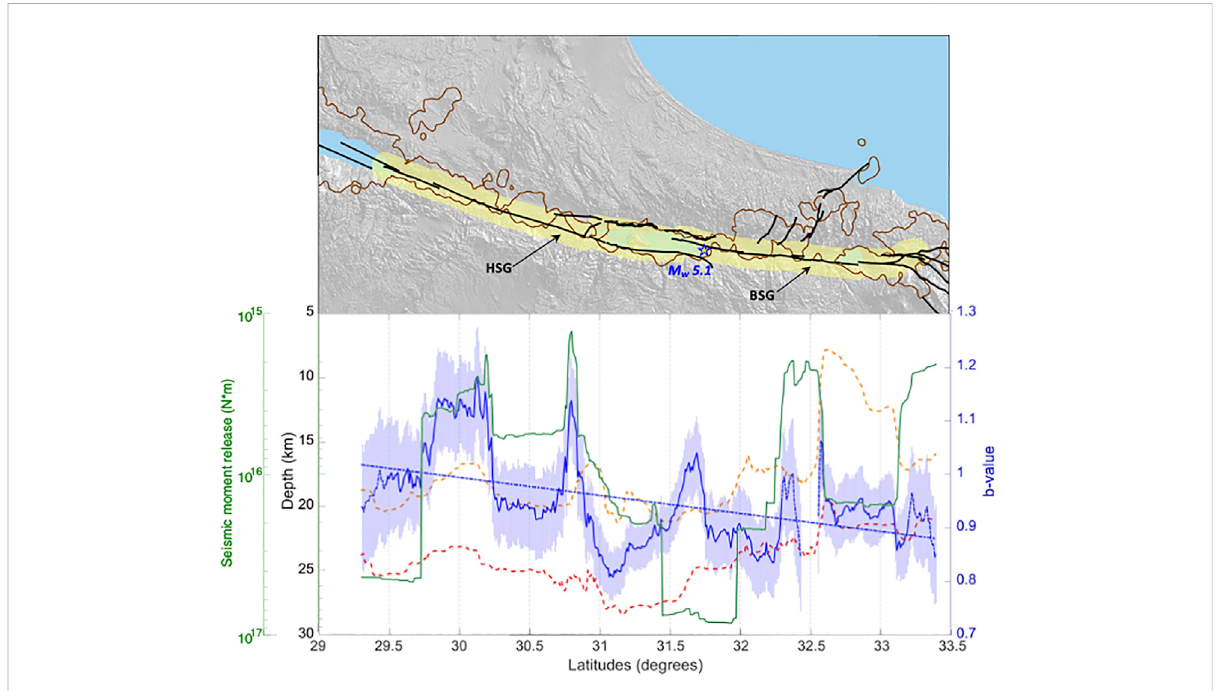
FIGURE 7 Top part: Map showing the DST polygon (yellow), de fi ning the data for the analysis. The black lines show the main sources (see Sharon et al., 2020). Bottom part: Spatial variations of the b-value (in blue), of the 75th and 95th hypocentre depth percentiles (dashed yellow and red lines, respectively) and of the cumulative seismic moment release (in Green). Note the left axes are directed downwards. Solid and dashed lines of the b-value indicate at least 100 events, and 50 – 99 events per sample, respectively, and are shown with their light blue error bar band surrounding them; the blue linear dashed curve marks the spatial trend of the b-value . Within the Top part, the brown polygon marks zones with high values of seismic density and seismic moment density (see Sharon et al., 2020), overlapping the DST polygon. These zones emphasize two seismic gaps: 1) HSG — Hazeva Seismic Gap (latitudes ~30.7 ° – 30.8 ° N), and 2) BSG — Beit She ’ an Seismic Gap (latitudes ~32.4 ° – 32.6 ° N); the latter is prominent enough to also leave a gap within the b-value pro fi le (Bottom